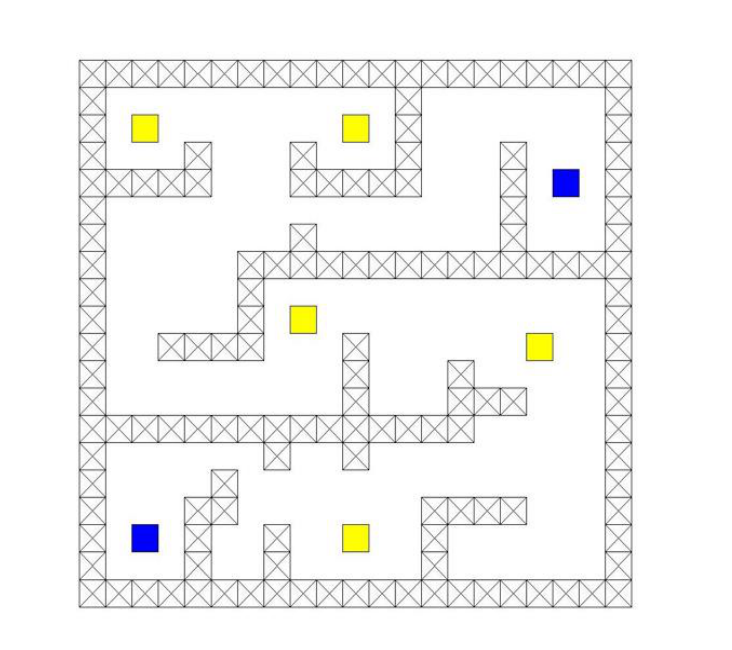
Fig. 1. Example of an operating area for a group of robots. Blue dots represent the locations of the robots, and yellow dots are the target.